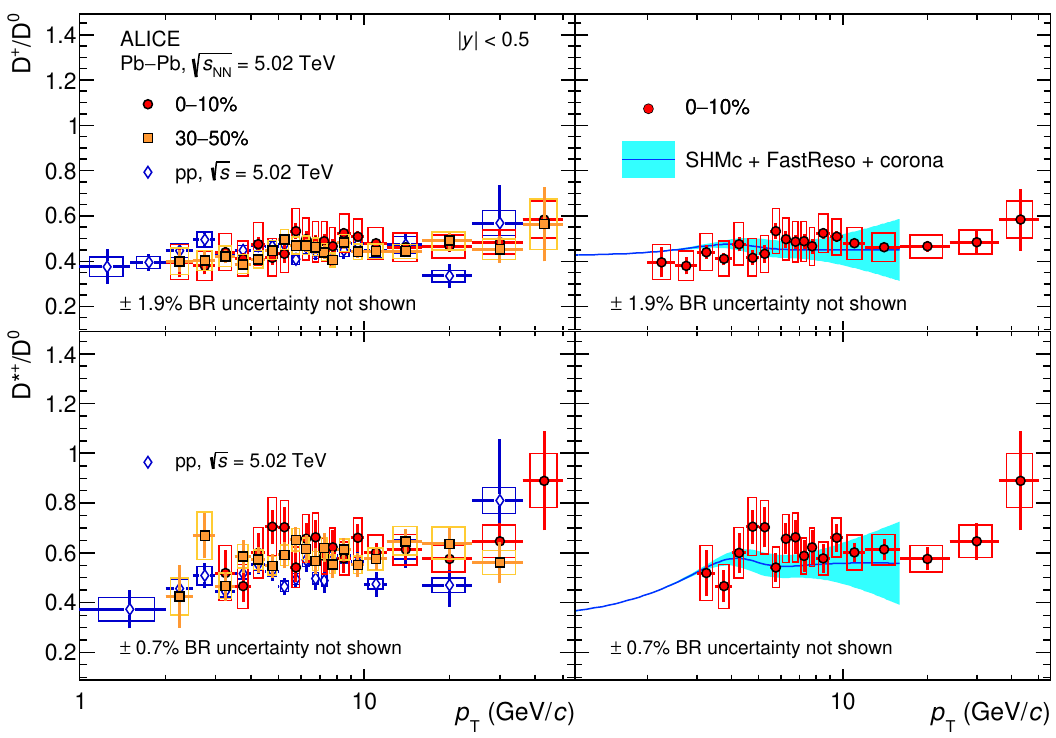
Figure 5 . D + / D 0 (top left panel) and D ∗ + / D 0 (bottom left panel) ratios as a function of p T in central and semicentral Pb–Pb collisions compared to the results obtained from pp collisions [37]. The right panels show the ratios in central Pb–Pb collisions compared to the predictions from the statistical hadronisation model (SHMc) [66, 67] with a core-corona approach and the FastReso package [68] for resonance decays. Statistical (bars) and systematic (boxes) uncertainties are